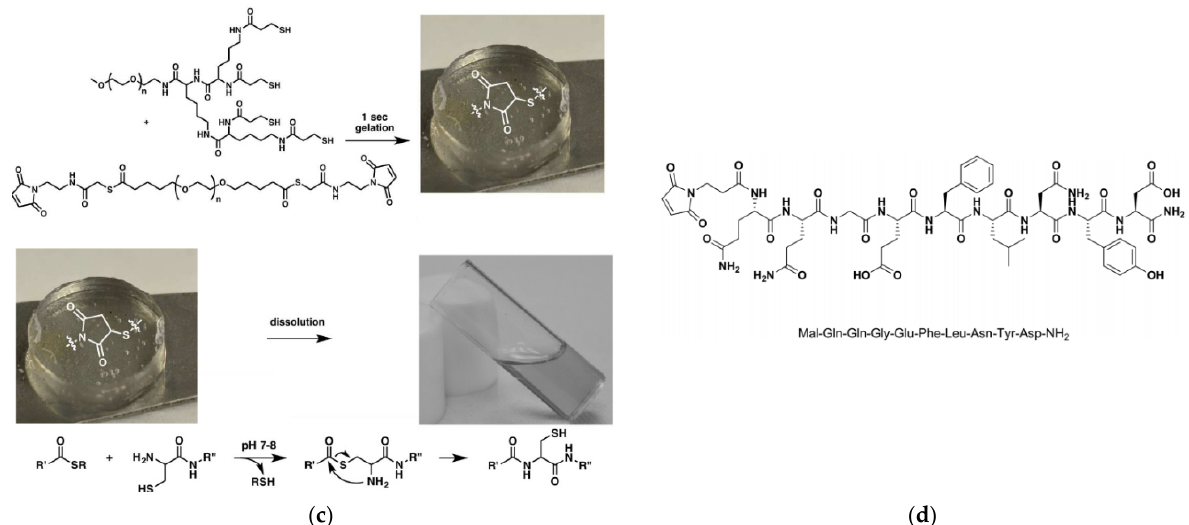
Figure 35. ( a ) SEM images of human HEP G2 cells on HAPG4PPy/PCL (A) and HAPG6PPy/PCL (B) electrospun nanofibers. Reproduced with permission from [289]. Copyright: Taylor & Francis; ( b ) Schematic comparison of hippocampal neuron adhesion to (A) linear and (B) dendrigraft polyly- sine-coated poly(glycolic acid) fibers and SEM images of primary cultured hippocampal neurons on fibers with and without coating with dendrigraft polylysine (G5) Expanded images in the left panels are shown in the right panels. Reproduced with permission from [290]. Copyright: Wiley Periodicals, Inc. ( c ) Chemical reaction scheme for the hydrogel formation upon mixing the lysine dendron with the PEG crosslinker, and for the subsequent dissolution with a cysteine methyl ester. Reproduced with permission from [291]. Copyright: Elsevier Inc. ( d ) Chemical structure of modified HSA-28 peptide. Reproduced with permission from [294]. Copyright: Royal Society of Chemistry. Table 7. Cartilage hepatic aortic neural and pancreatic cell development by the mediation of den- dritic polymers.